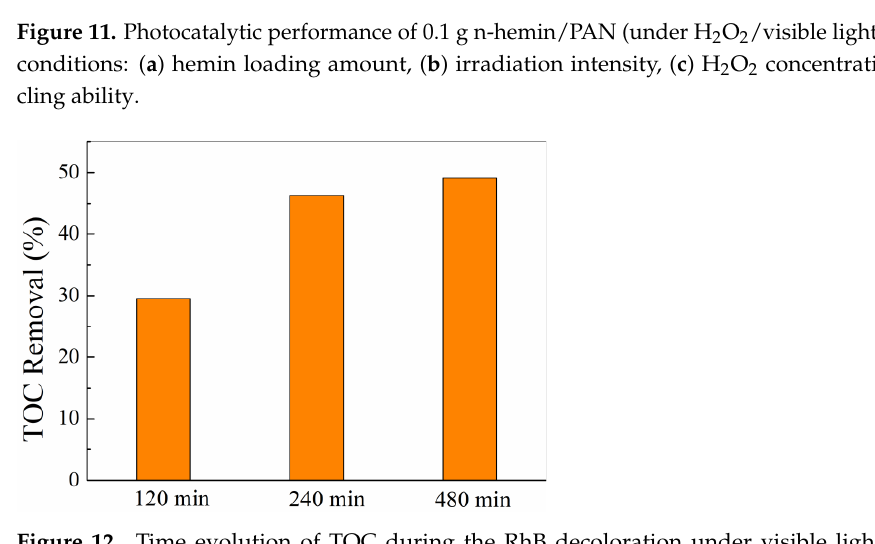
Figure 11. Photocatalytic performance of 0.1 g n-hemin/PAN (under H 2 O 2 /visible light) in different conditions: ( a ) hemin loading amount, ( b ) irradiation intensity, ( c ) H 2 O 2 concentration, ( d ) recycling ability.